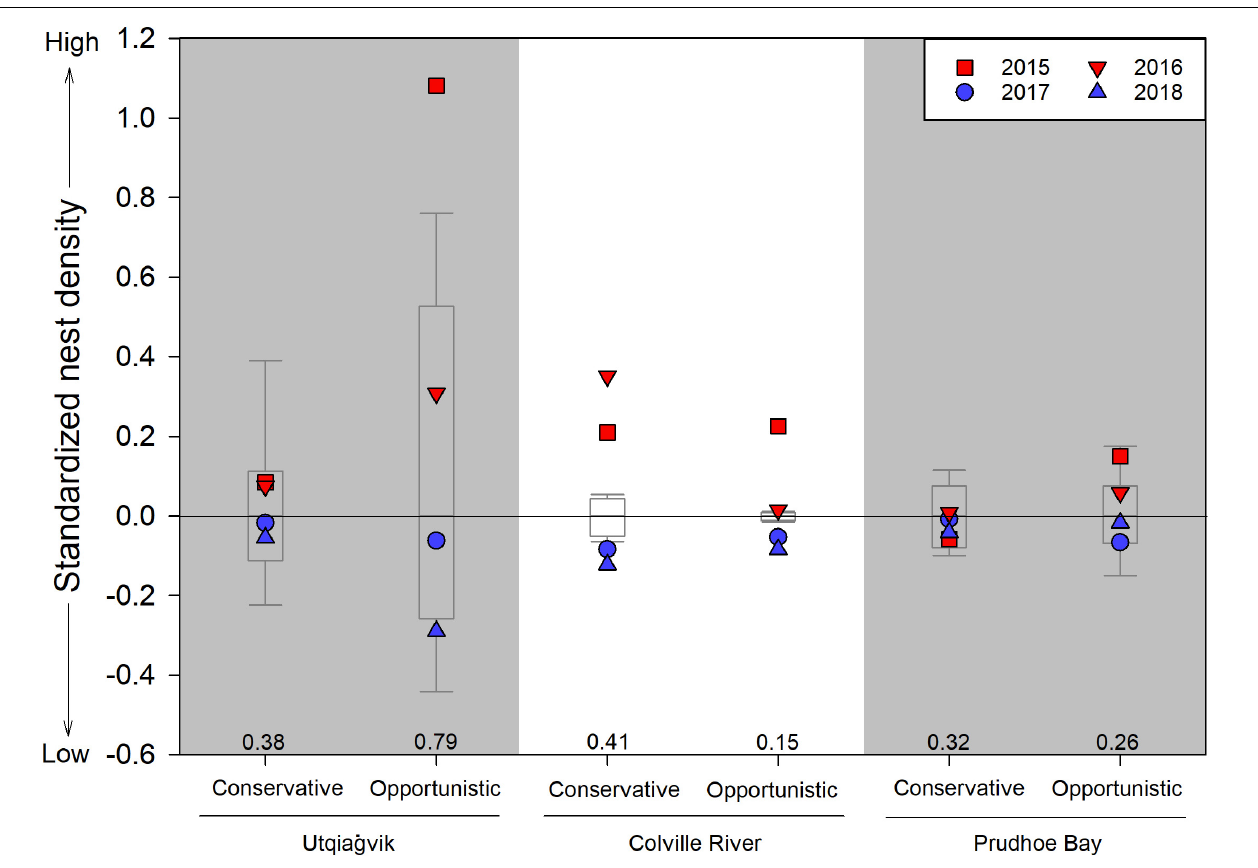
FIGURE 3 | Standardized shorebird nest densities by opportunistic and conservative reproductive strategies in 2015–2018 in relation to long-term values (i.e., Utqia˙gvik: 2005–2014; Colville River: 2011–2014; Prudhoe Bay: 2005–2014). Data are standardized for each year and reproductive strategy separately by subtracting from them the long-term median value (median values listed above x-axis); box plots represents the 25 th and 75 th percentiles with error bars at the 10 th and 90 th percentiles and the line crossing at the median value. Early springs (i.e., 2015 and 2016) are illustrated in red while late springs (i.e., 2017 and 2018) are illustrated in blue. See Table 2 for species assignments to reproductive strategies and sample